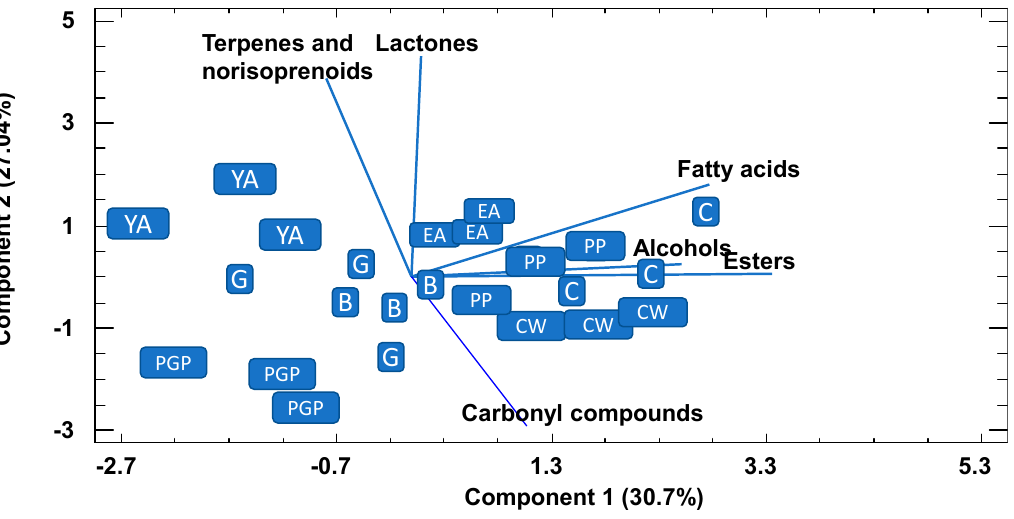
Figure 2. Bidimensional plot of the different fined wines using the first two components resulting from a principal component analysis using the different families of the volatiles compounds as variables.